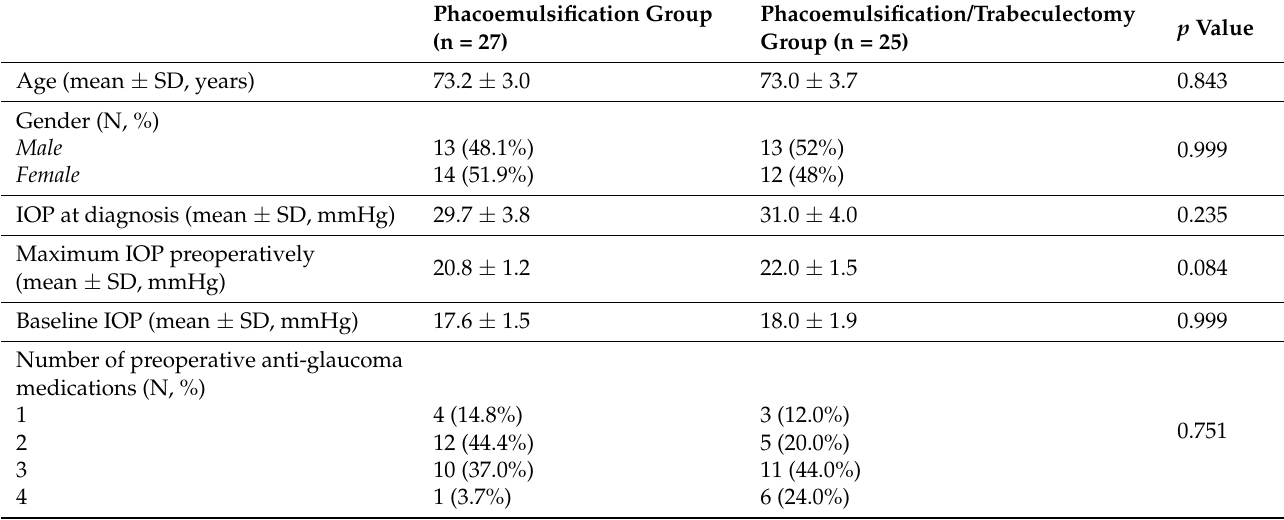
Table 1. Demographic and clinical characteristics of our study sample.